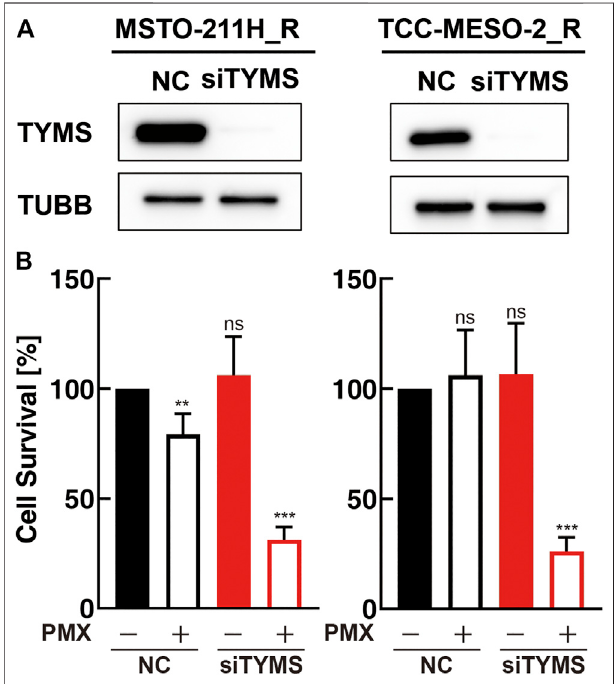
FIGURE 3 | TYMS knockdown decreased resistance to pemetrexed (PMX). MSTO-211H_R or TCC-MESO-2_R cells were transfected with either negative control siRNA (NC) or TYMS siRNA (siTYMS). (A) Protein levels of TYMS or β -tubulin (TUBB) in whole-cell lysates were determined by western blot analysis. TUBB was used as a loading control. (B) Viability of transfected cells treated with PBS or PMX (1 μ M) for 72 h was determined by WST-8 assay. The % viability data are shown as the mean ± standard deviation (SD) ( n (cid:2) 6). Error bars indicate the range of SD. ns; not signi fi cant, * p < 0.05,** p < 0.01,*** p < 0.001vs.control(NC,PMX-)byOne-WayANOVA using for graph pad